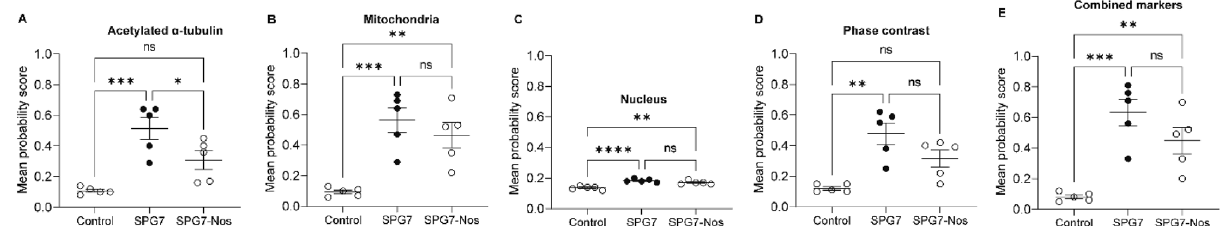
Figure 8. Logistic regression analysis of noscapine-treated SPG7 patient cells. We compared noscapine treated SPG7 patient cells (16,379 cells from 5 individuals) to untreated control and SPG7 patient cells presented above in the SPG7 vs controls section (Fig. 4) for comparison. Noscapine-treated patient cells had logistic regression probability values comparable to controls for acetylated α-tubulin ( A ). The markers mitochondria ( B ), nucleus ( C ), phase contrast ( D ) and all markers combined ( E ) were comparable to untreated SPG7 samples. Mean values were compared using one way